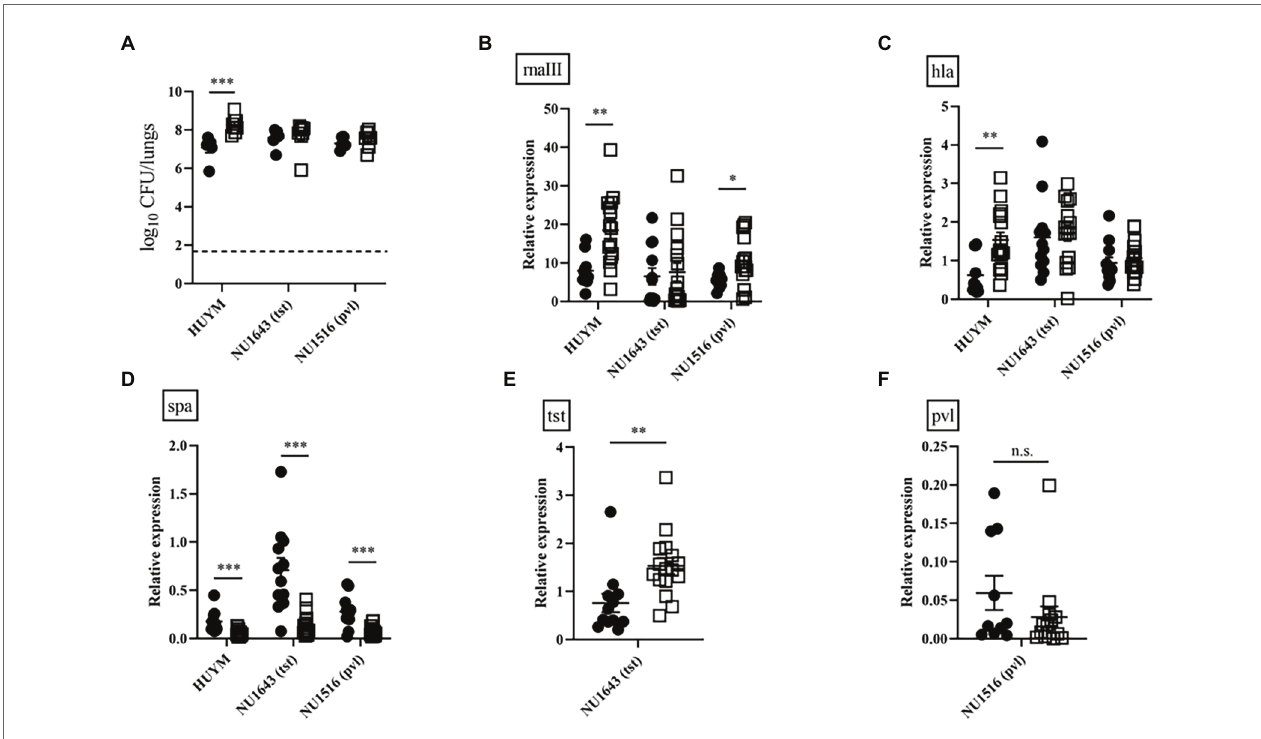
FIGURE 6 | (A) Bacterial loads in the lungs of mice infected with the MRSA strains (HUYM, NU1643, and NU1516) at 1 × 10 8 CFU/mouse for lethal infection. Bacterial counts were validated 4 h ( ● ) and 16 h ( ◽ ) after infection. Bars represent mean bacterial counts, n = 6–8 mice/group. The broken horizontal line represents the lower limit of detection (1.7 log10 CFU/ml of lung specimen). Similar results were obtained from two independent experiments. Transcript levels of (B) rnaIII, (C) hla, (D) spa, (E) tst, and (F) pvl measured 4 h ( ● ) and 16 h ( ◽ ) after inoculation in mice infected with MRSA strains (HUYM, NU1643, and NU1516). Bars represent the mean relative mRNA expression. Data are representative of 6–8 mice from two independent experiments. * p < 0.05; ** p < 0.005; *** p < 0.001; and n.s., not